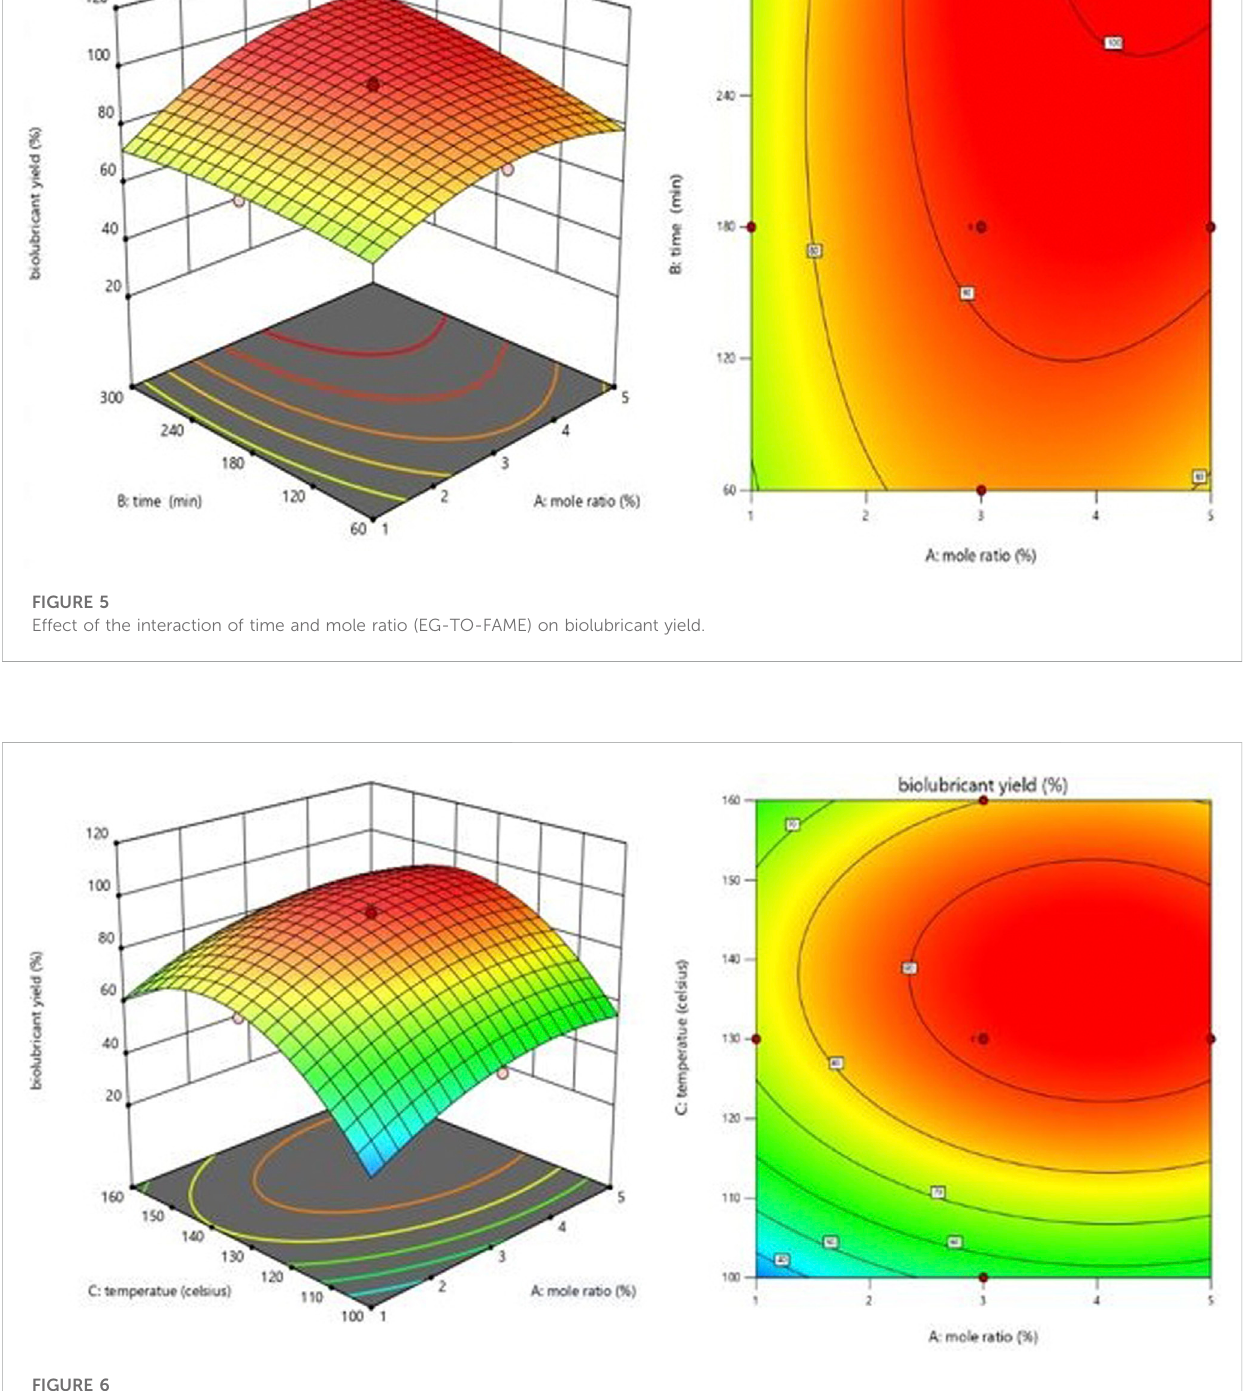
molar ratio of 5:1 and obtained a jatropha biolubricant yield of 84.38%. Yunus et al. (2003) reported the optimal synthesis